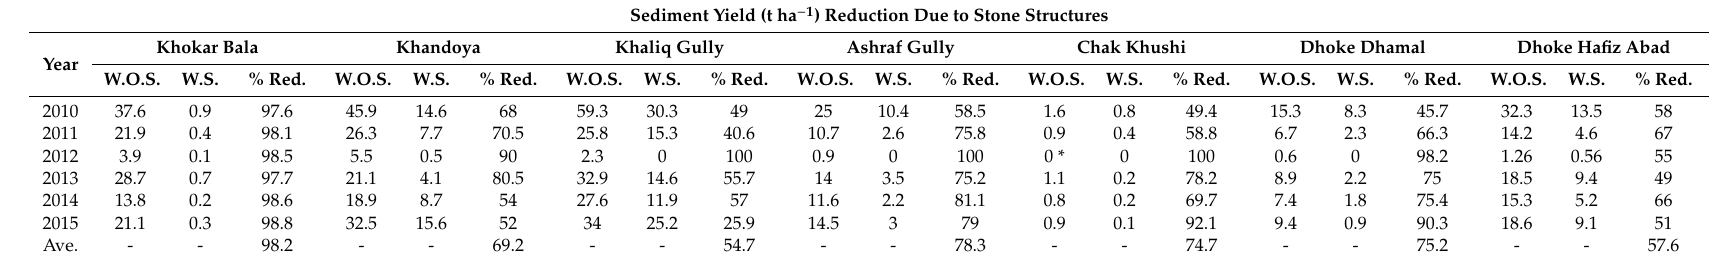
Table 3. The e ff ect of stone structures on the sediment yield